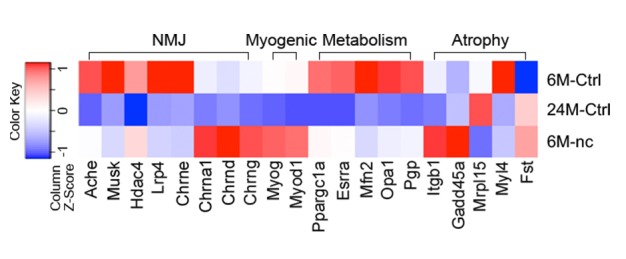
Aged skeletal muscle does not display transcriptional changes characteristic of denervation.Heat map of FPKM values from uninjured adult (6M-Ctrl) and aged (24M-Ctrl) gastrocnemius and adult gastrocnemius after 6 weeks of denervation-reinnervation upon a 2 mm sciatic nerve transection surgery (6M-nc). Red indicates increased expression, and blue indicates decreased expression. The data represent pooled replicates of 6M-Ctrl (n = 3), 24M-Ctrl (n = 2) and 6M-nc (n = 3) mice.